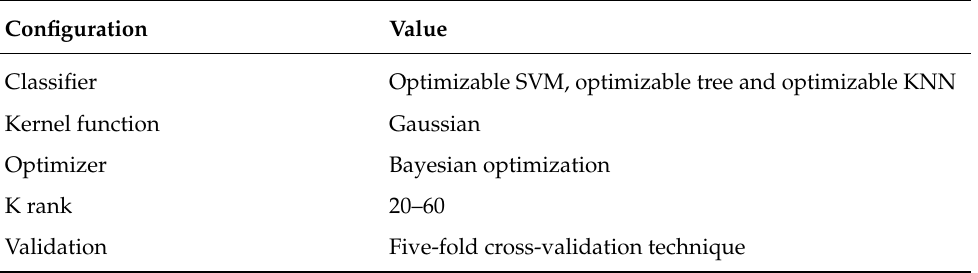
Table 9. Hyperparameter configuration for the feature extraction